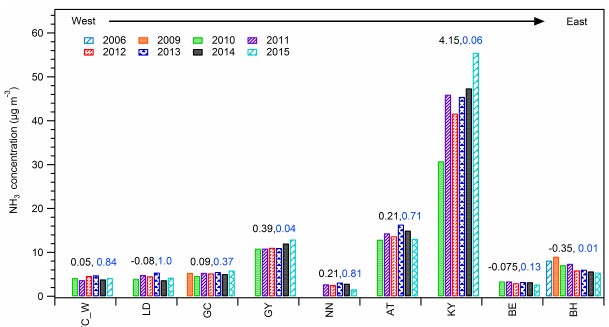
Figure 2. Average concentrations of NH 3 in each summer (approx- imately June through August) across the nine sites. In 2006 (6 July– 10 August), ambient NH 3 concentrations were sampled by a URG denuder (daily) at the BH site; in 2009 (11 June–27 August) ambi- ent NH 3 concentrations were sampled by a URG denuder (weekly) at the GC and BH sites; in 2010 (17 June–2 September), 2011 (16 June–31 August), 2012 (21 June–29 August), 2013 (20 June–29 August), 2014 (19 June–28 August) and 2015 (23 June–1 Septem- ber), ambient NH 3 concentrations were all sampled by Radiello NH 3 passive samplers across all the sites. Trend analysis (annual concentration vs. time) was conducted at each site. The slope of the Theil regression and p value for each site are labeled in black and